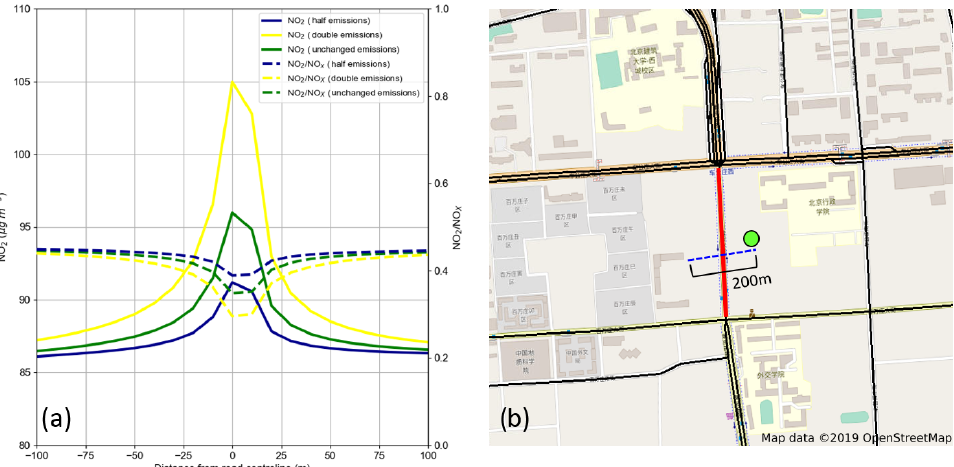
Figure 8. (a) Campaign period mean simulated NO 2 concentrations and NO 2 / NO x concentration ratios with distance from the road centre along the cross-road slice marked in (b) using half (blue), double (yellow) and unchanged (green) emissions of all species from an explicit road source marked by red line. The green circle in (b) marks the position of monitoring site 1. (b) © OpenStreetMap contributors 2019. Distributed under a Creative Commons BY-SA